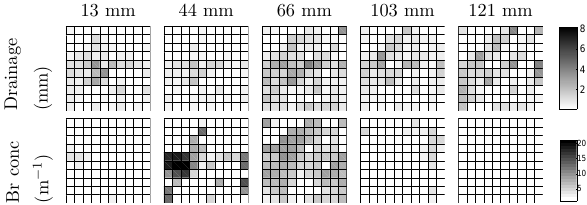
Fig. 4. Spatial distributions of the drainage, and the bromide concentration during the snowmelt experiment over the multi- compartment sampler consisting of 10 × 10 cells of 3 . 15 × 3 . 15cm 2 each. The bromide concentration is scaled with the applied mass per m 2 . The titles refer to the cumulative drainage since solute applica- tion.